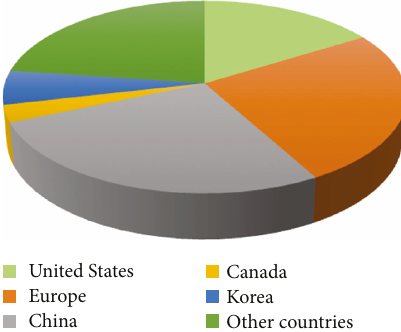
Figure 1: The clinical trial distribution of MSC-based immunomodulation in the world. Up to now, most of the clinical trials using MSCs for treating in fl ammatory or autoimmune diseases have been conducted in the China, US, and Europe. All values have been extracted from